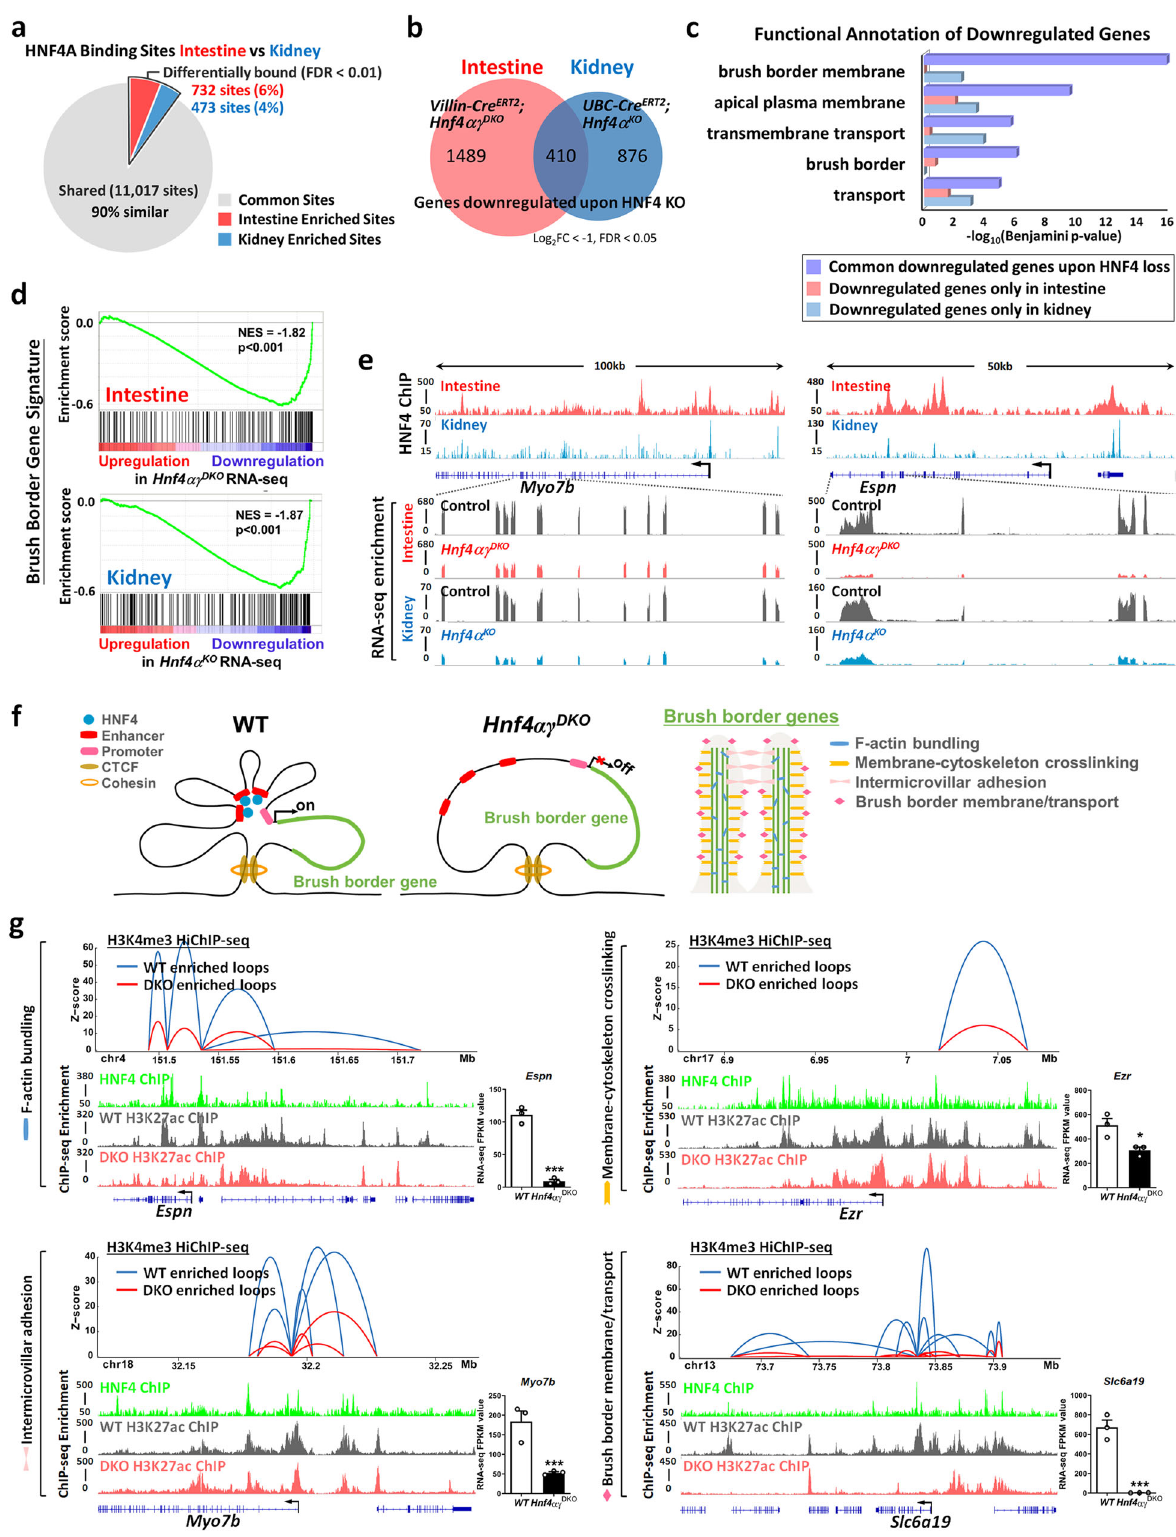
phosphatase (AP, a brush border membrane-bound enzyme), β - protein of the brush border), and Ezrin (linking the cytoskeleton to the cell plasma membrane of the brush border) were